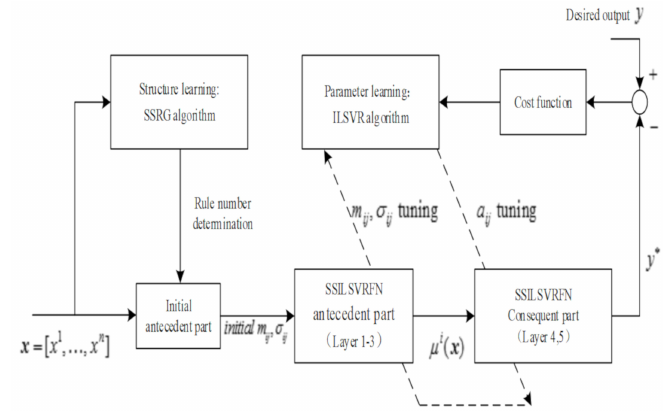
Figure 6. The SSILSVRFN